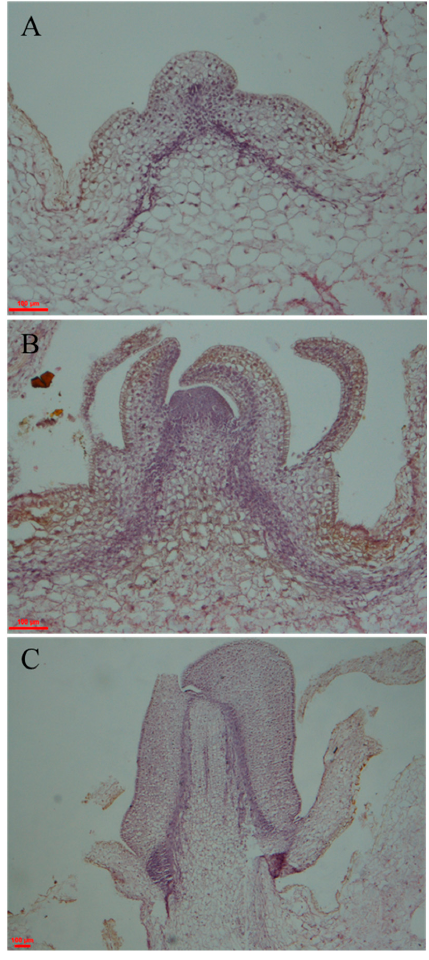
Figure 1. Observation and identification of the morphological changes in potato dormant tubers ( A ), dormancy release tubers ( B ), and sprouting tubers ( C ). Scale bar = 100 μ m.